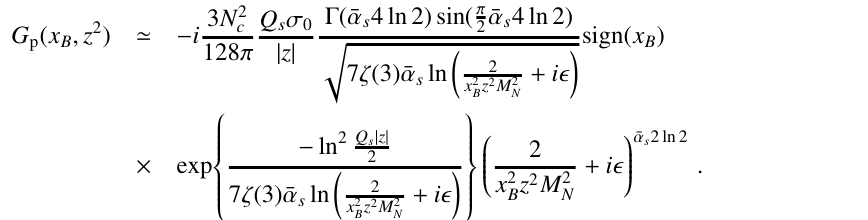
Performing the Fourier transform first, and taking the saddle point approximation for the integration over the ν parameter at the end, we have